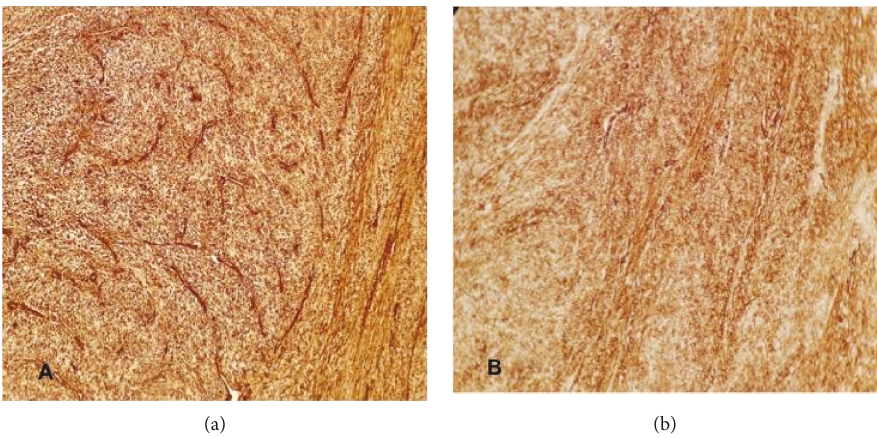
Figure 3: The spindle cells show strong and di ff use positivity for (a) CD34 and (b) bcl2; ( ×